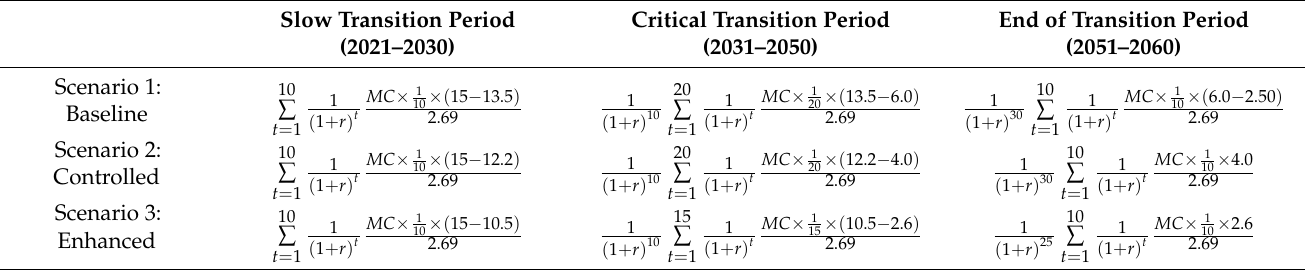
Table 2. Cost calculation.